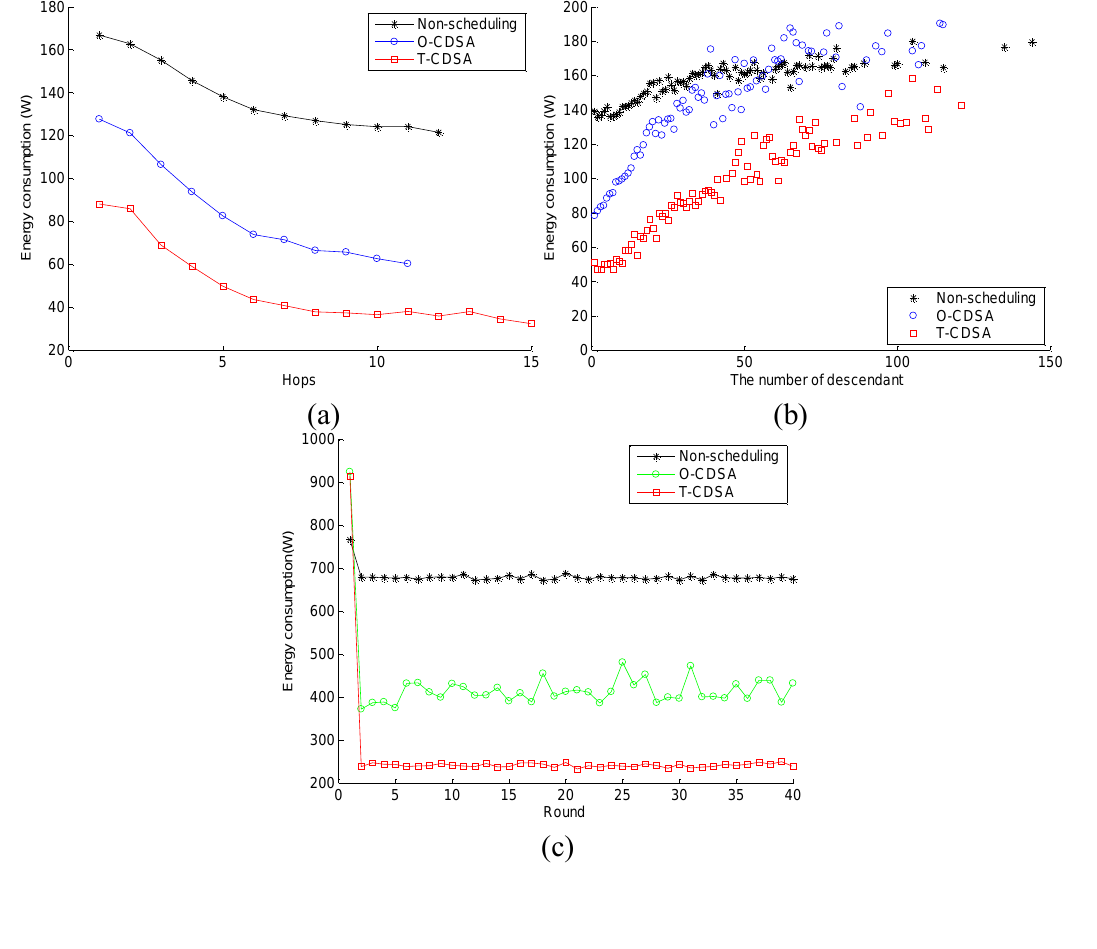
Figure 11. Energy consumption analysis: (a) Average energy consumption versus the hop of nodes. (b) Average energy consumption versus the number of descendants of nodes. (c) Total energy consumption in WSN at each